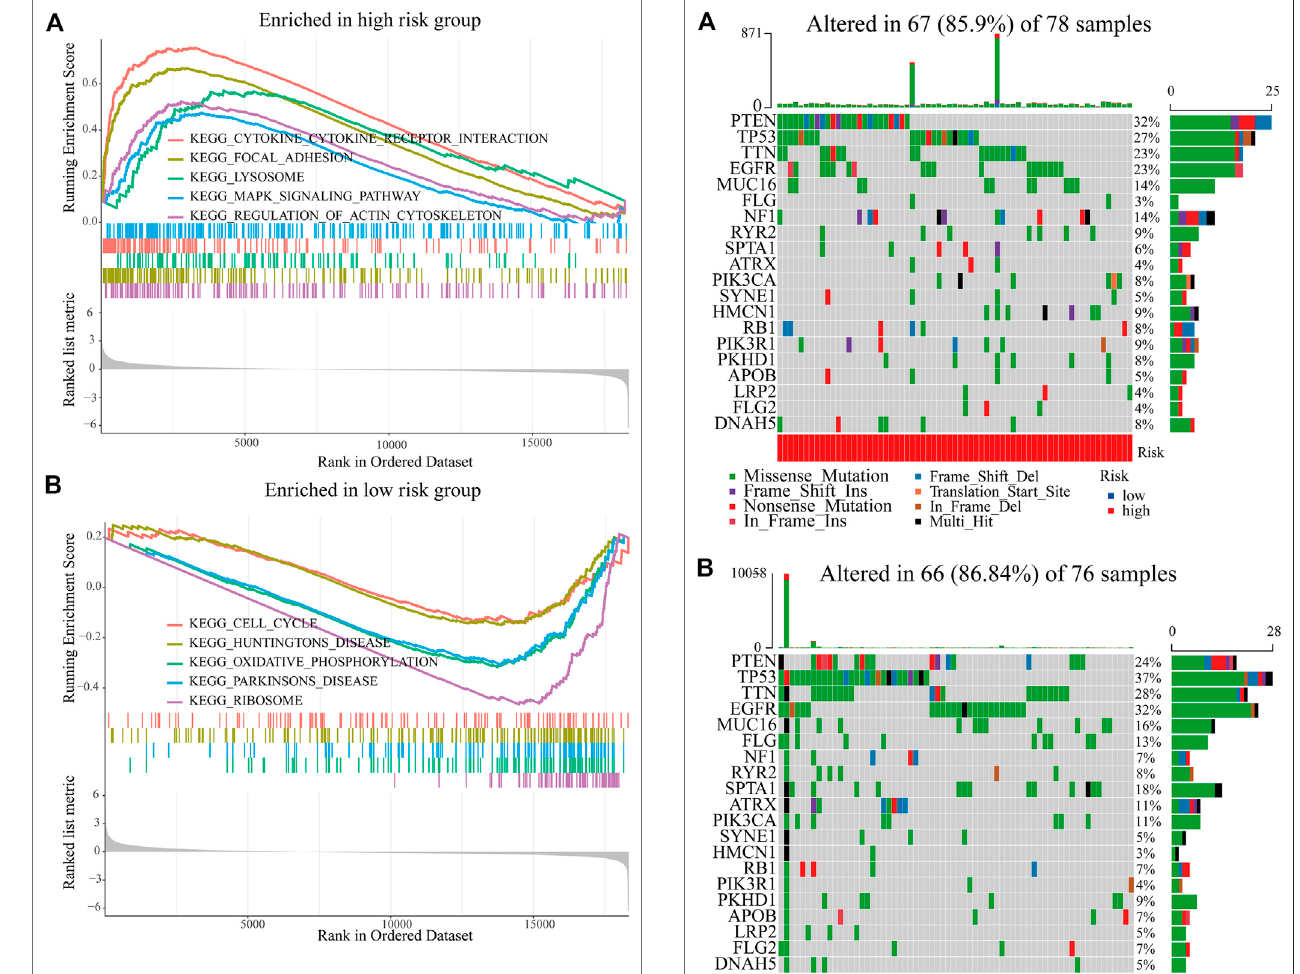
FIGURE 5 | GSEA of KEGG pathway enrichment analysis of the prognostic risk model (PRM) in the TCGA database. (A) High-risk group. (B) Low-risk group.